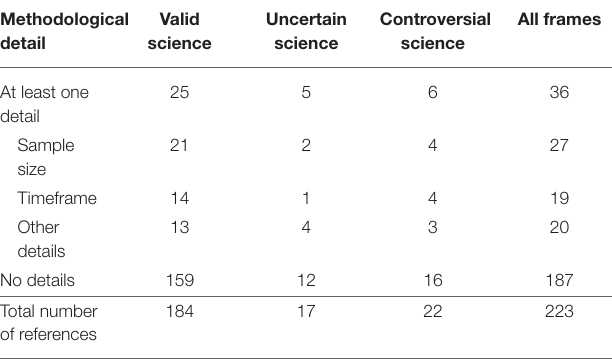
TABLE 5 | Research references that included details about the research design and methodology, grouped by